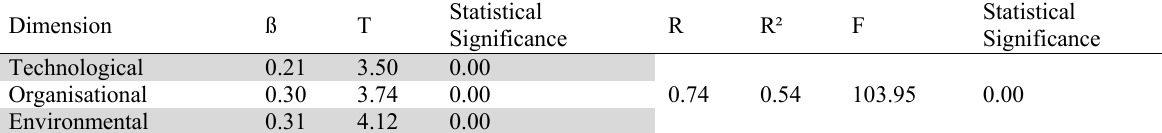
Results of Applying the Multiple Regression Equation to Study the Impact of Adopting E-Collaboration Tools on Knowledge Generation Statistical Dimension ß T